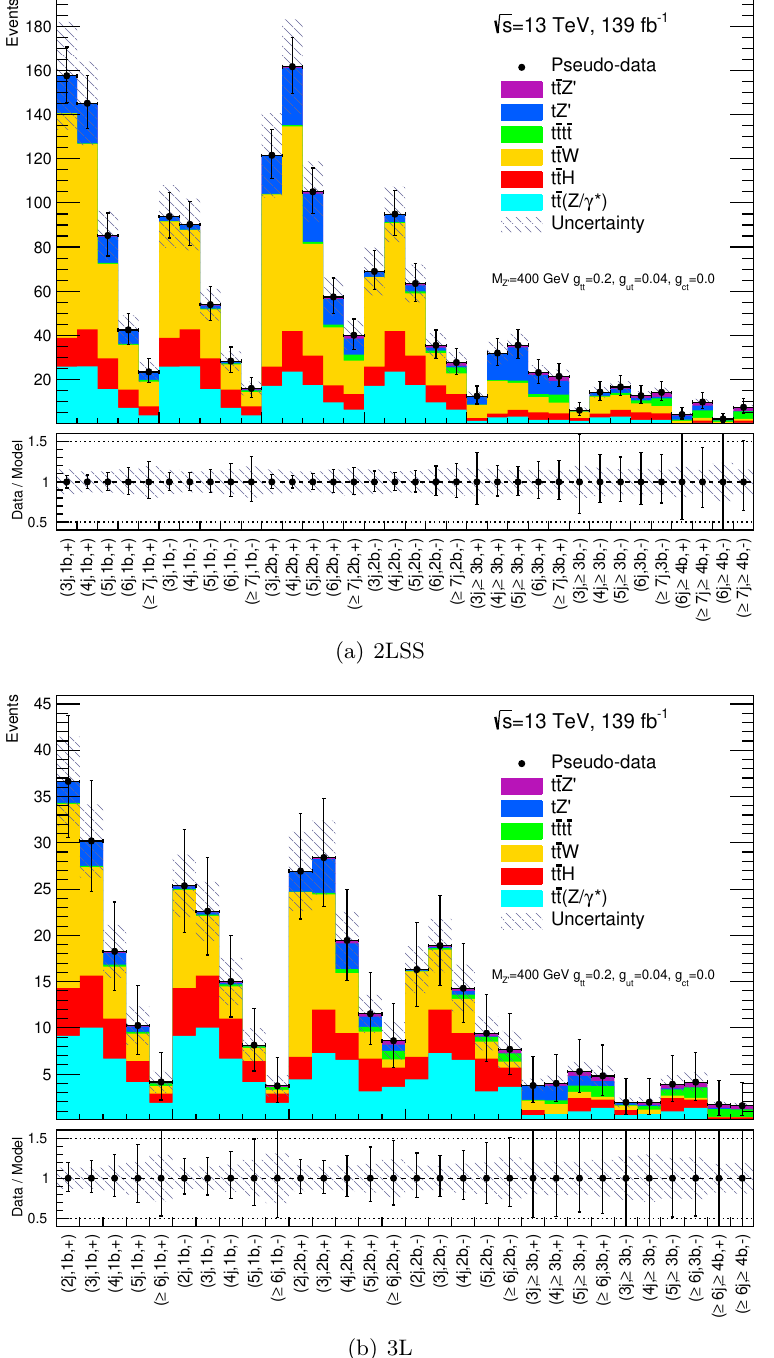
Figure 8 . Global event yields for tZ 0 , ttZ 0 and the main irreducible backgrounds for the benchmark point M = 400 GeV, g = 0 . 04 , g = 0 . 0 and g = 0 . 2 . Each bin consists of a global selection Z 0 ut ct tt criteria on N , N , and Q , as explained in the j b lep